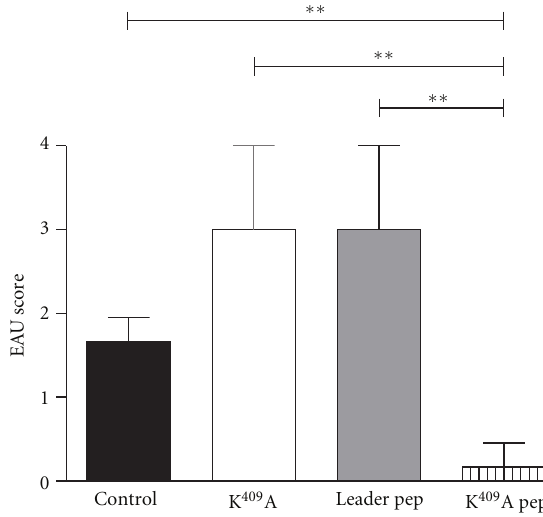
Figure 1: Administration of K 409 A protein and Leader pep increased EAU scores, and injection with K 409 A pep decreased EAU scores. B10.RIII mice were immunized with 40 μ g 161–180 IRBP peptide on day 0 and followed by a single injection with 2.5 μ g of K 409 A, Leader pep, or K 409 A pep (i.p.). Eyes were collected for histopathology 21 days after immunization. EAU scores were assigned by histopathologic examination of the eyes on a scale from 0 to 4 according to the extent of inflammation and tissue damage. ∗∗ P < 0 . 01: control versus K 409 A pep; K 409 A versus K 409 A pep; Leader pep versus K 409 A pep. Disease incidence: control group: 75% of animals presented grade 1.5; K 409 A: 75% of animals expressed grade 3; Leader pep: 75% of animals presented grade 3; K 409 A pep: 75% of animals expressed no disease.